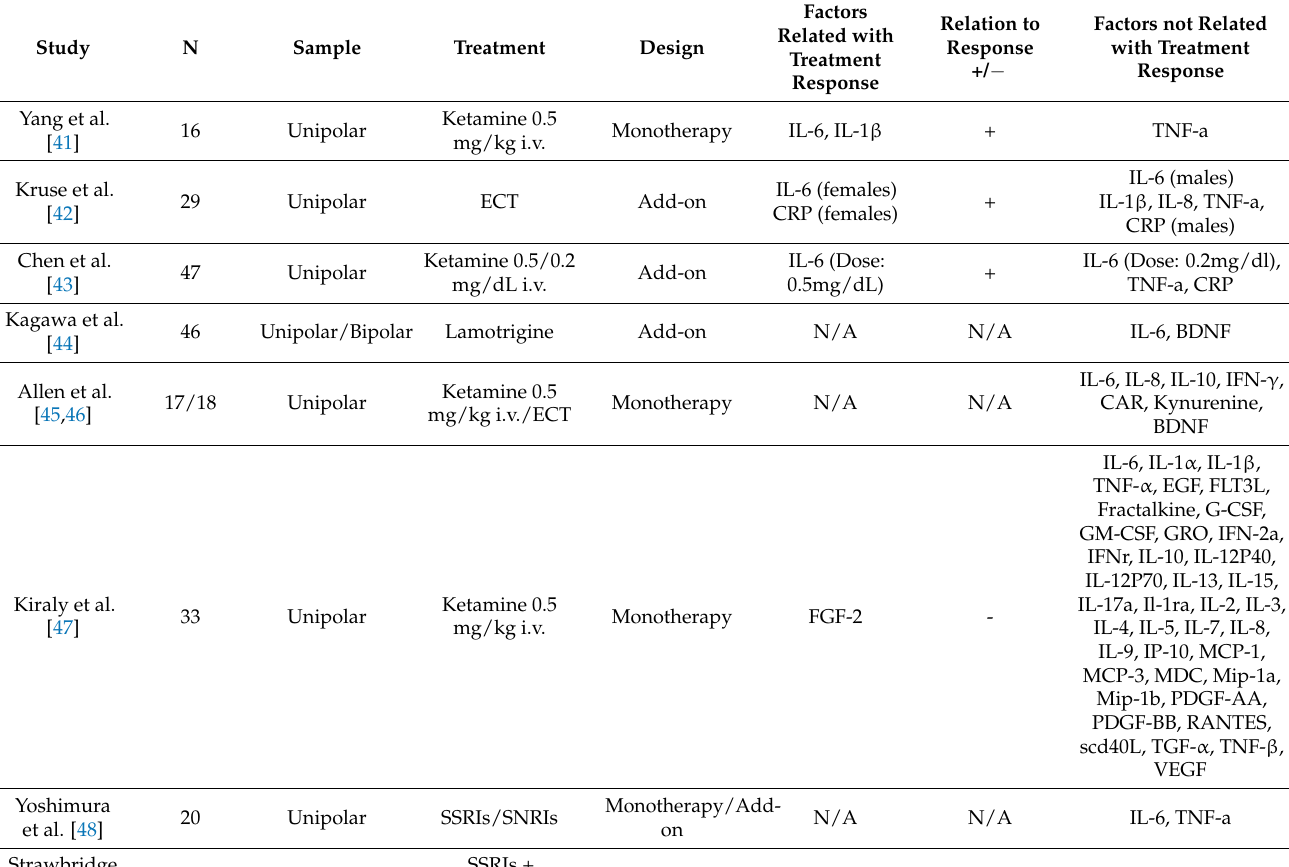
Table 1. Overview of studies assessing the prognostic significance of blood-based baseline biomarkers of responses to treatment in